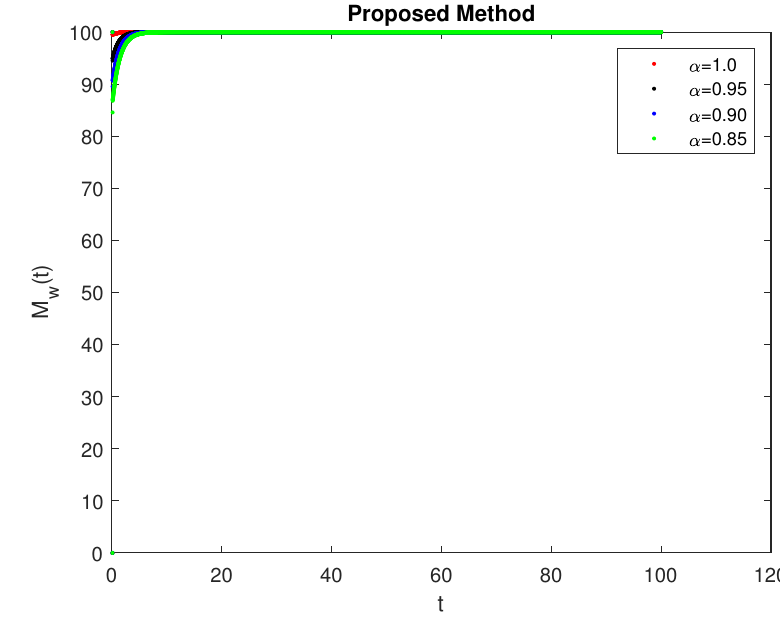
Figure 21: Numerical simulations for τ = 1 for Caputo-Fabrizio derivative.